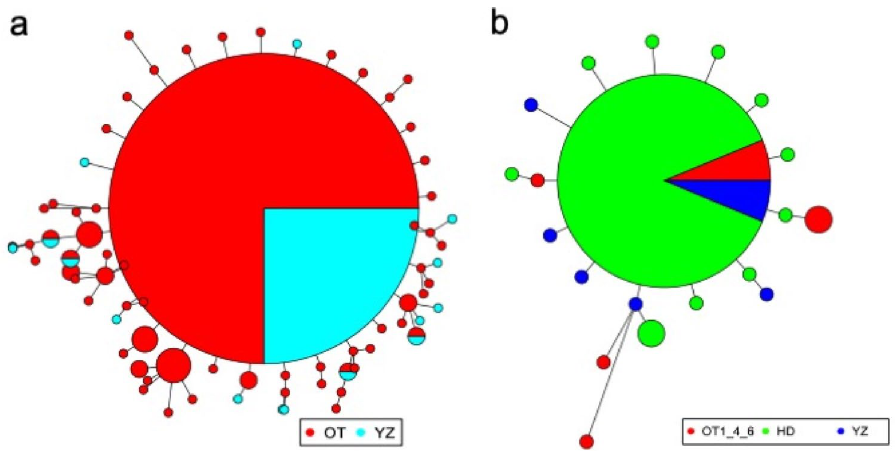
Figure 2. Haplotype networks of synaphobranchid eels. ( a ) Simenchelys parasitica . ( b ) Synaphobranchus kaupii . Each color corresponds to a population